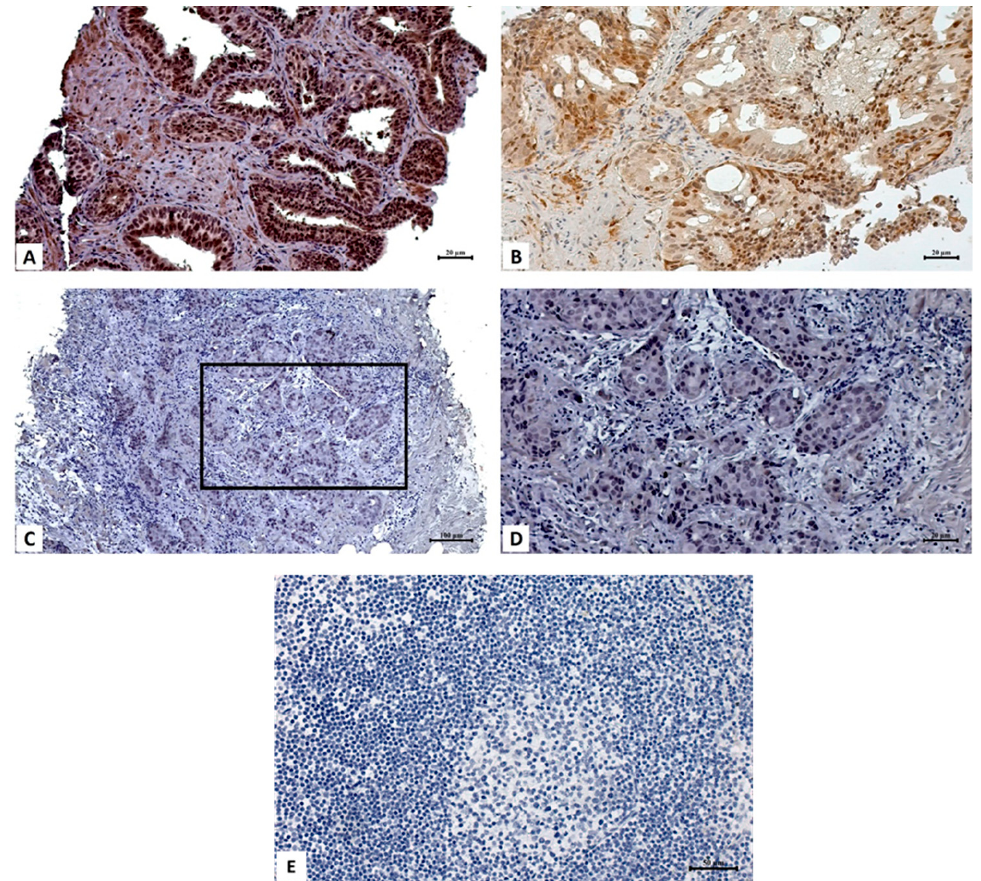
Figure 2. Immunohistochemical analysis. ( A ) Image shows high ZNF750 protein expression in both nucleus and cytoplasm of prostatic hyperplasia cells (scale bar represents 20 µm). ( B ) Non-metastatic prostatic acinar adenocarcinoma, Gleason 8 (4 + 4), characterized by high nuclear and weak cytoplasmic ZNF750 expression (scale bar represents 20 µm). ( C ) No ZNF750 expression in metastatic prostatic acinar adenocarcinoma, Gleason 8 (4 + 4) (scale bar represents 100 µm). Square represents the high magnification in panel ( D ). ( D ) Absence of ZNF750 staining in both nuclear and cytoplasmic compartments (scale bar represents 20 µm). ( E ) ZNF750 staining performed on lymph node tissue as a negative control for ZNF750 immunohistochemical reaction (scale bar represents 50 µm). Table 2. (A) Evaluation of ZNF750 cytoplasmatic staining in normal prostate and prostatic acinar adenocarcinomas of patients with and without metastasis. (B) Evaluation of ZNF750 nuclear stain- ing in normal prostate and prostatic acinar adenocarcinomas of patients with and without metasta- sis.